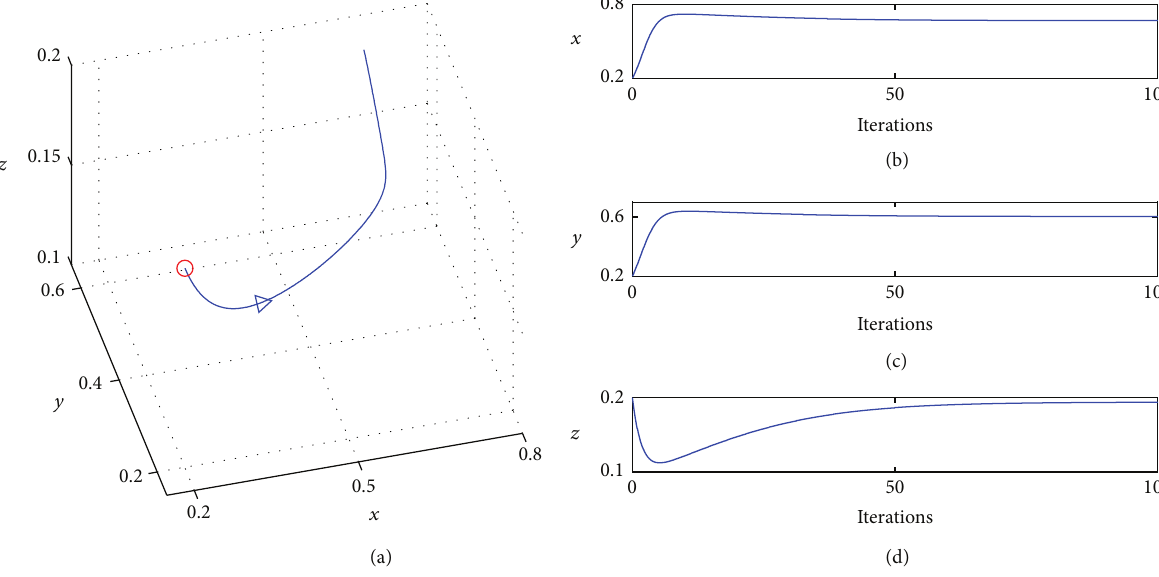
Figure 2: (a) A phase portrait of system (1) with initial condition (0.2, 0.2, 0.2) and (b)–(d) time series for 𝑥 1 (𝑡), 𝑥 2 (𝑡) , and 𝑦(𝑡) , respectively, when 𝑎 1 = 0.8, 𝑏 1 = 1, 𝑎 2 = 0.7, 𝑏 2 = 1, 𝑐 = 0.8, 𝑑 = 0.5, 𝑒 1 = 0.9, 𝑒 2 = 0.3, 𝛼 = 1.3 , and 𝛽 = 0.5